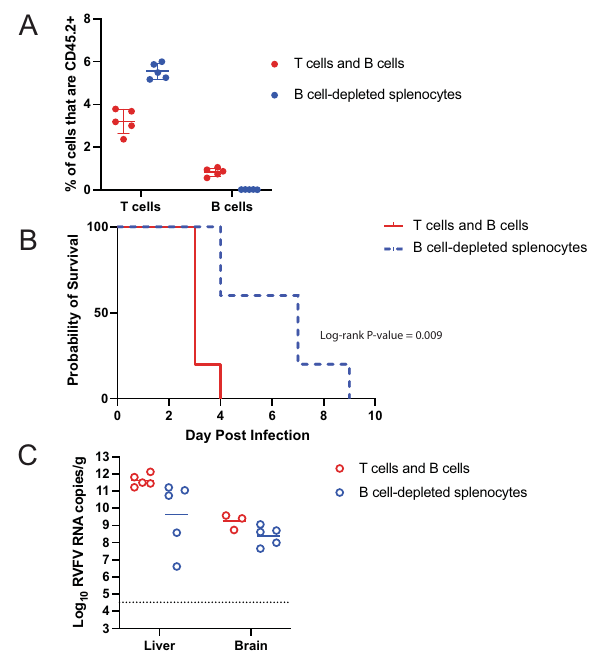
Fig. 5 Neither adoptive transfer of B and T cells or B cell-depleted splenocytes was suf fi cient to protect from WT challenge. Naïve CD45.2 mice ( n = 5 per experimental group) were vaccinated with 2 × 10 5 TCID 50 of DelNSsRVFV. On day 30 post-vaccination, total splenocytes were harvested and subjected to either negative selection for B and T cells or positive selection to deplete B cells. Naïve recipient CD45.1 mice were given either a 1:1 mixture of immune B and T cells or B cell-depleted immune splenocytes. The number of donor-derived (CD45.2) B cells and T cells present in the blood of recipient animals 1 day after transfer was determined by fl ow cytometry ( A ). Mean and standard deviation are noted. Mice were challenged with 2 TCID 50 WT RVFV, and then monitored